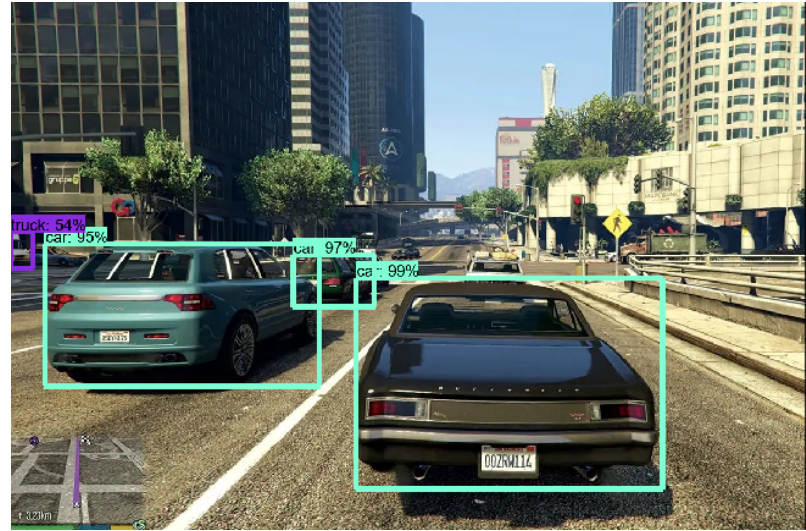
Figure 8. Image analysis through Faster R-CNN: car.